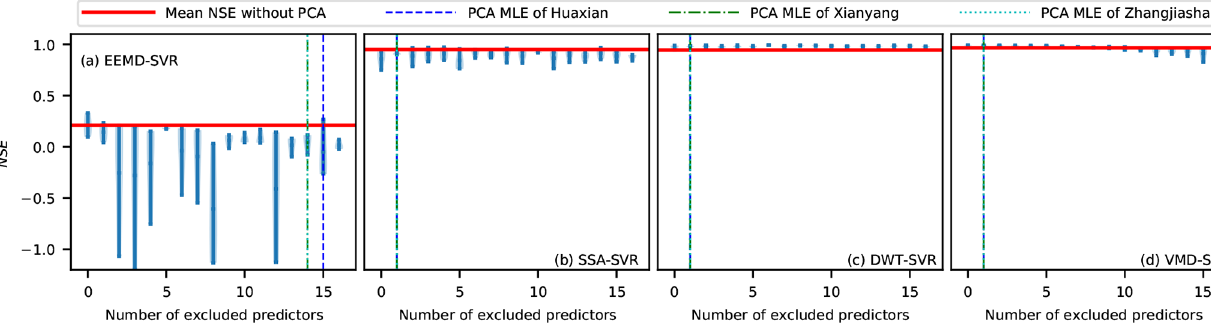
for the time-series data of the Xianyang and Zhangjiashan